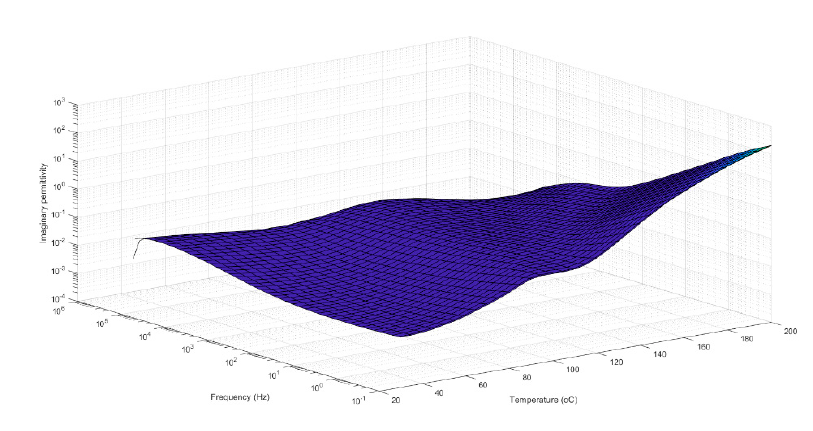
Figure 8. Dielectric losses of PET as functions of temperature and frequency.